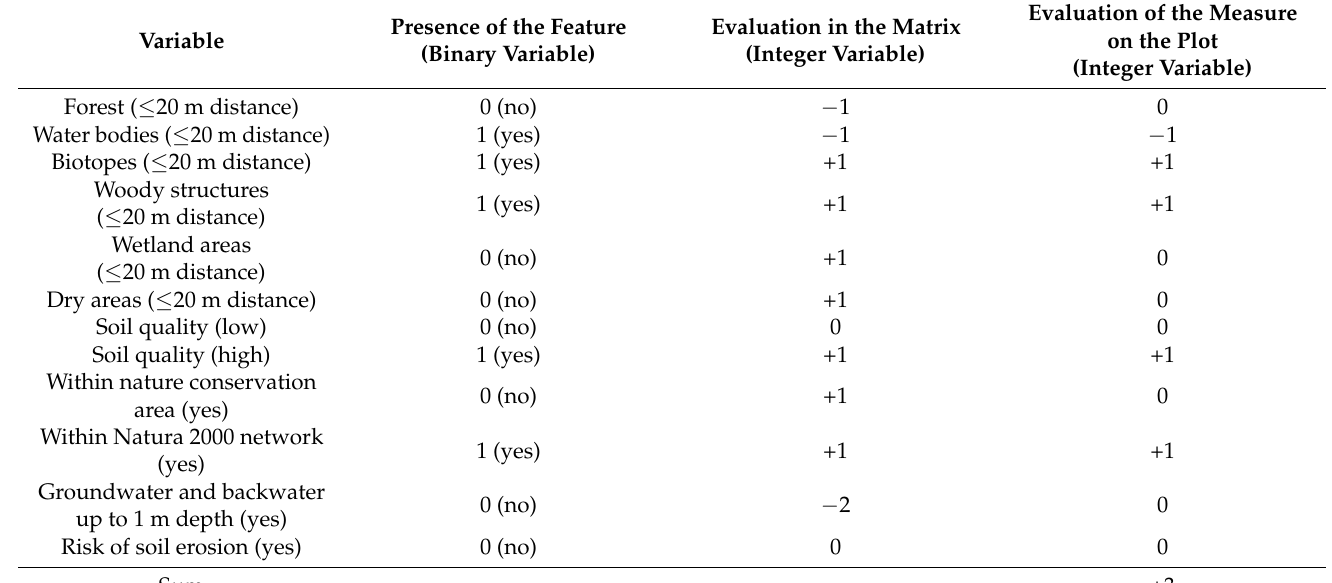
Table 5. Example calculation of the evaluation of a measure (permanent flower strips from a nature conservation point of view) on a specific field in the model using the field-level